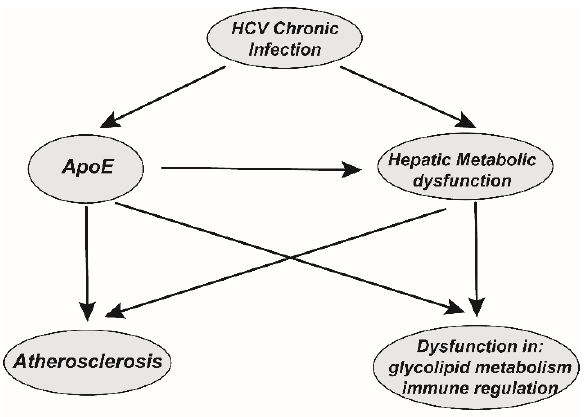
Figure 5. The potential correlation between HCV chronic infectious and HCV-associated comorbidities. HCV chronic infection induces persistent hepatitis and liver metabolic dysfunction. In addition, HCV participates in the long-term hijacking of ApoE, which further promotes the dysfunction of liver metabolic function. On the one hand, liver metabolic dysfunction caused by chronic infection may lead to systemic dysfunction of glycolipid metabolism. On the other hand, ApoE deficiency is associated with atherosclerosis and glycolipid metabolism and immune regulation dysfunction. Thus, persistent hijacking of ApoE by chronic HCV infection may potentially contribute to these diseases and may be the potential cause of comorbidities associated with chronic HCV